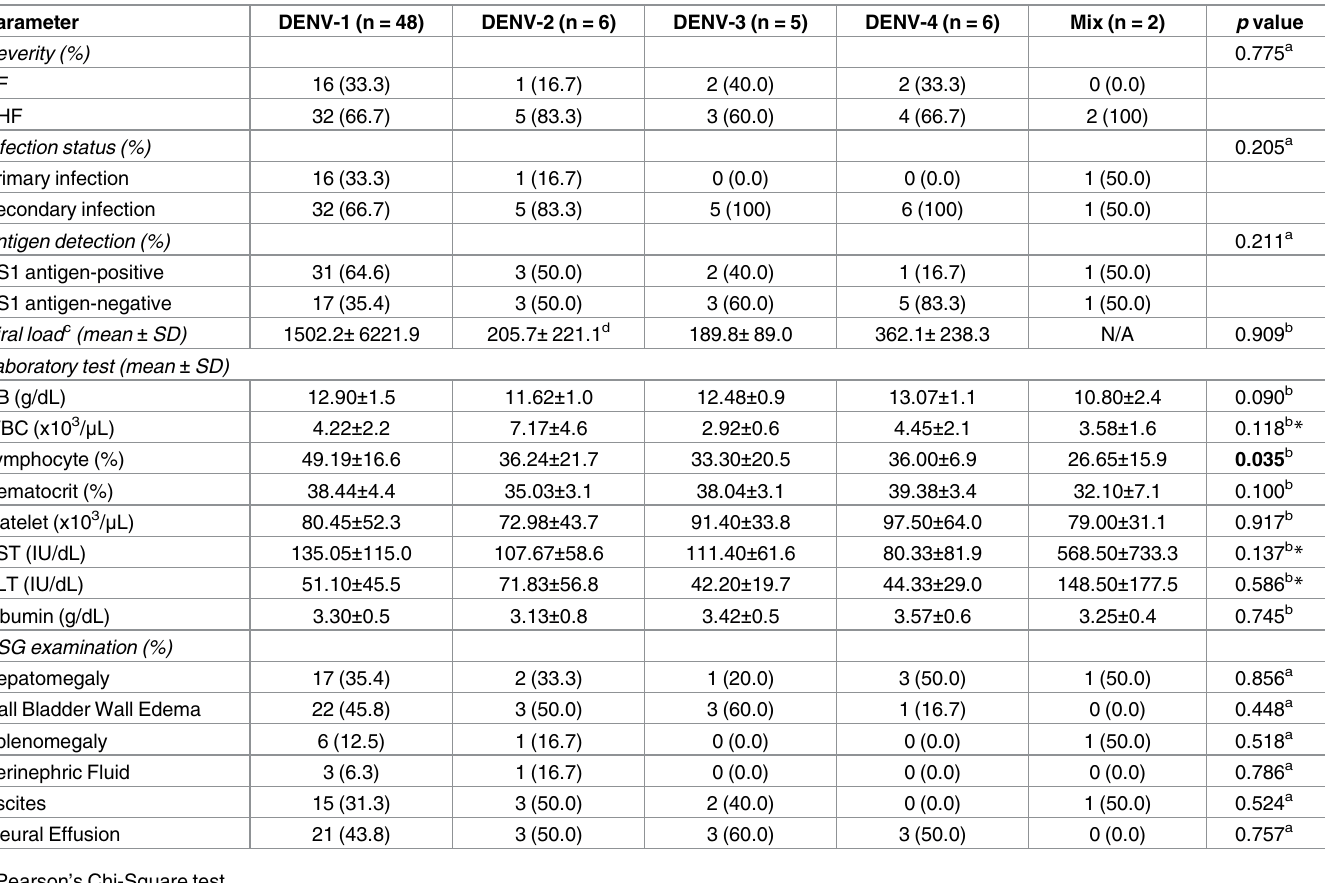
Table 4. Clinical and laboratory parameters of patients grouped according to infecting